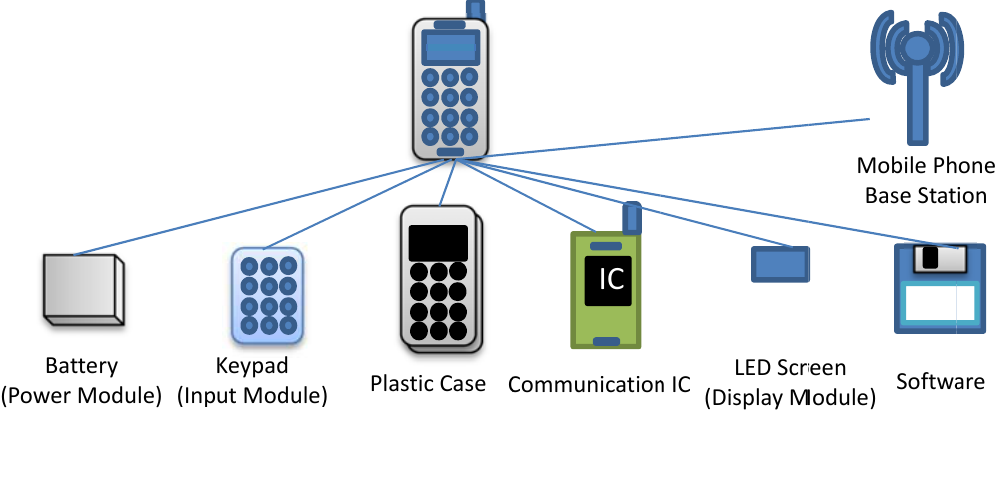
Figure 2. Mobile phone: